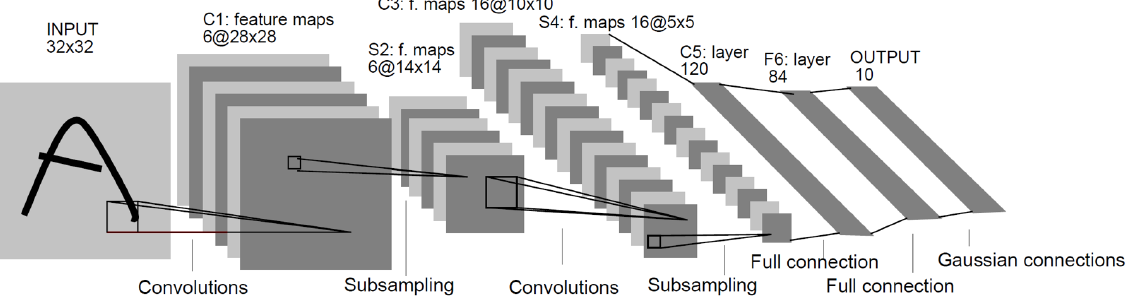
Figure 3. LeNet-5 CNN architecture [31].